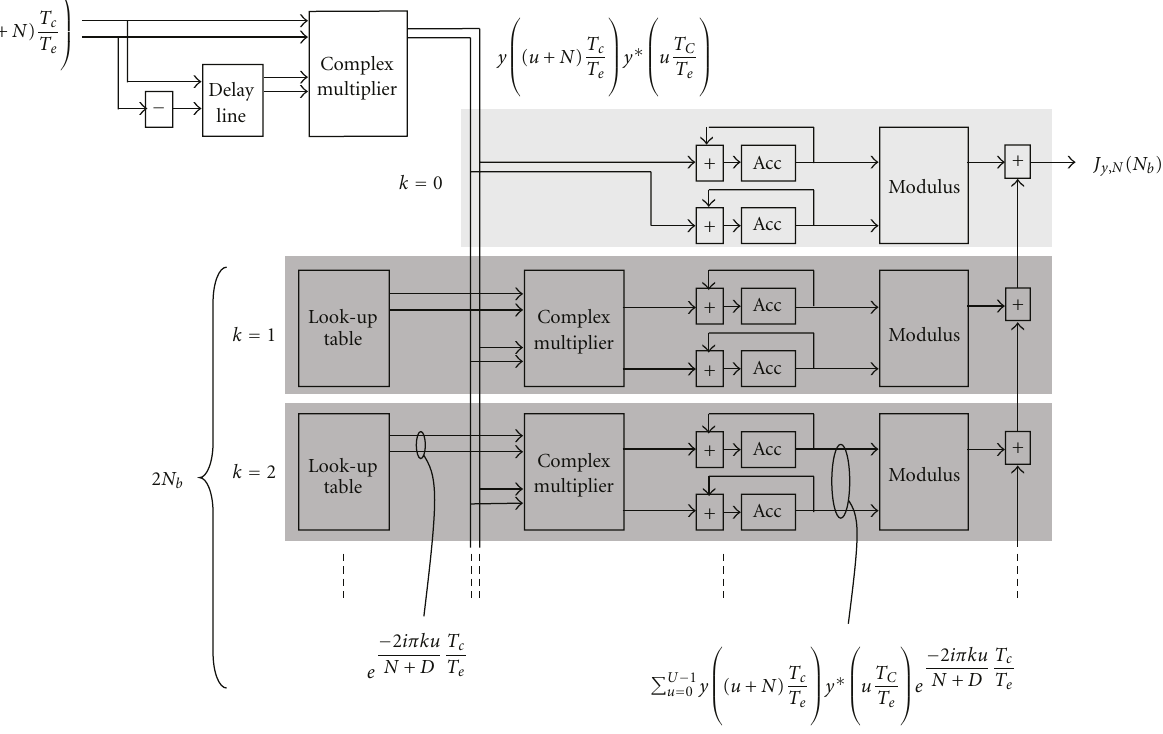
Figure 2: Cyclostationarity detector for WiFi